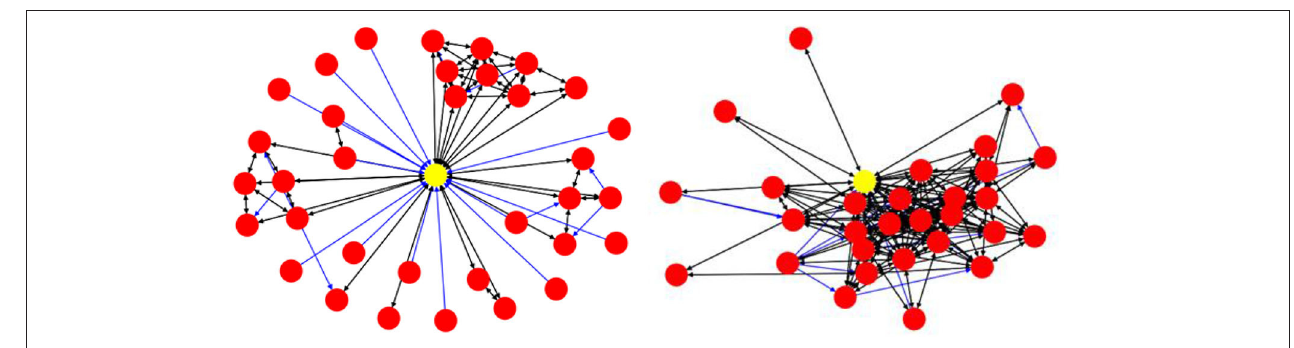
FIGURE 8 | A complete graph with 6 nodes and BC mean and spread.